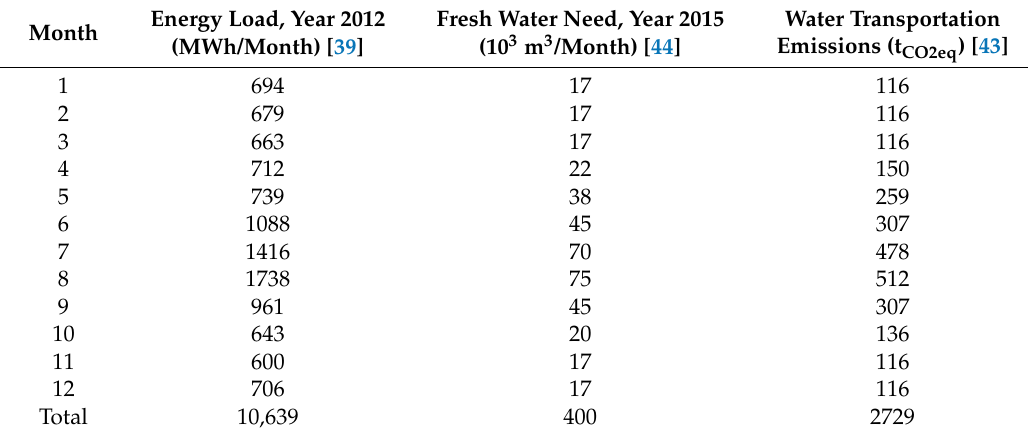
Table 1. Monthly distribution of energy and water needs of Ponza Island.